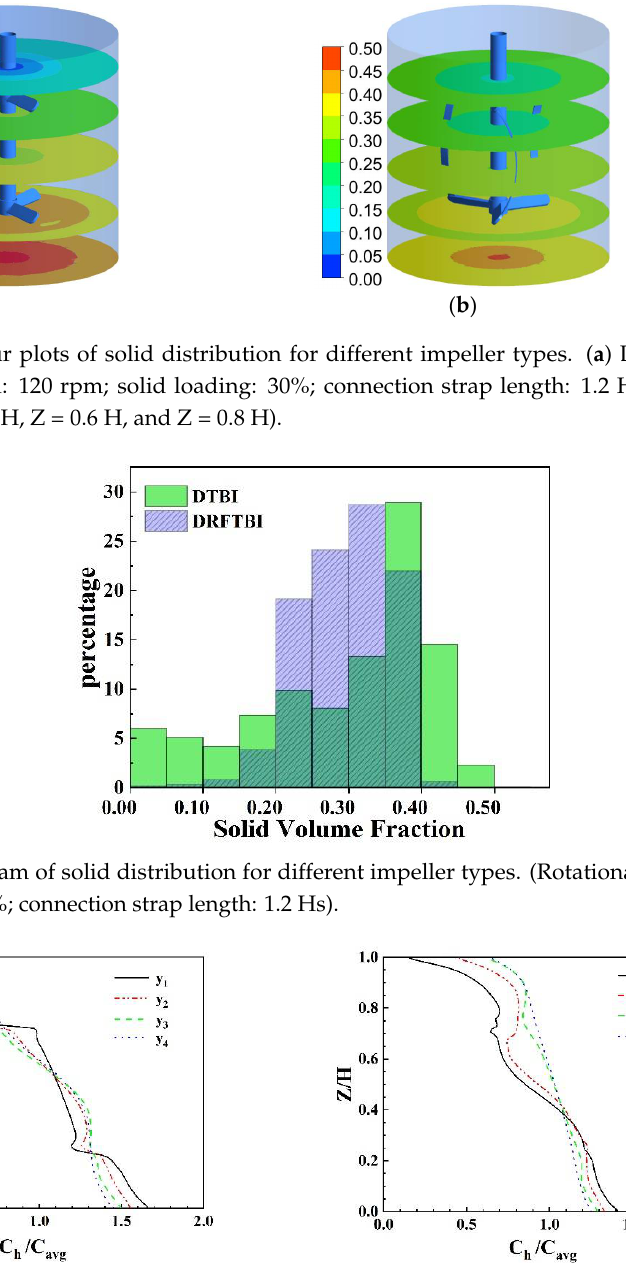
Figure 5. Contour plots of solid distribution for different impeller types. ( a ) DTBI; ( b ) DRFTBI. (Rotational speed: 120 rpm; solid loading: 30%; connection strap length: 1.2 H S ; plane: X = 0.)